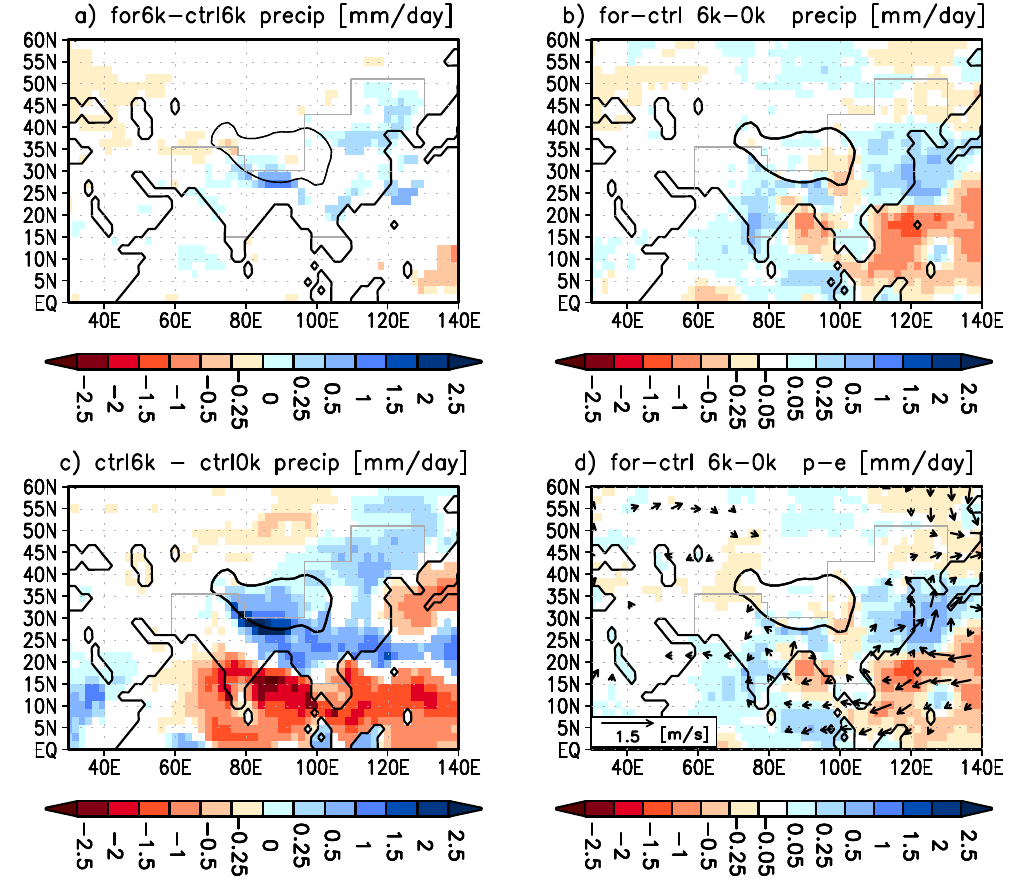
Fig. 14. Simulated precipitation change [mmday − 1 ] between different experiments, averaged over the monsoon season: (a) significant (95%, t-test) difference between the afforestation experiment (for) and the control run (ctrl) under mid-Holocene orbital conditions. (b) dif- ference of the afforestation-induced climate signal (forctrl) between the simulations with mid-Holocene (6k) and present-day (0k) orbital condition. (c) significant (95%, t-test) difference between the control run with mid-Holocene orbit and the control run with present-day orbit prescribed. (d) moisture convergence [mmday − 1 ] between for-ctrl under 6k-orbit and for-ctrl under 0k-orbit combined with the difference in 850hPa-wind [ms − 1 ]. Wind vectors with a magnitude of less than 0.15ms − 1 are not shown. Please note that the figures on the right panel do not only show significant